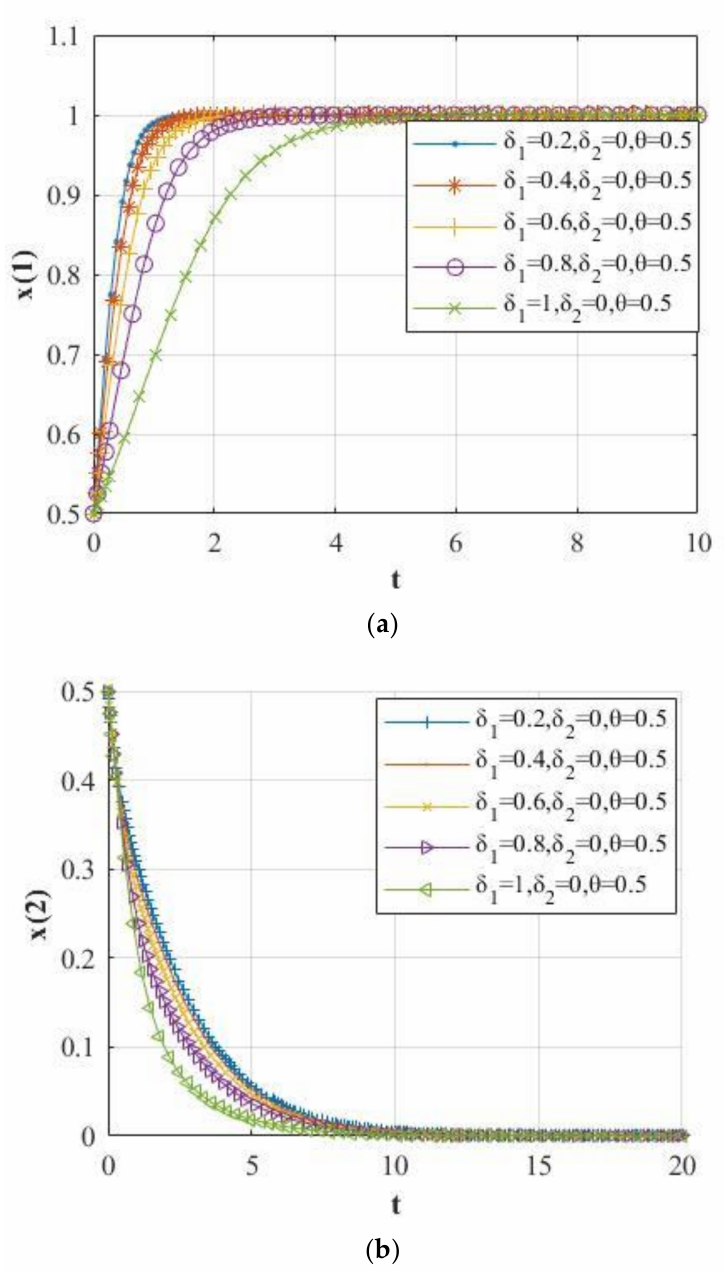
Figure 6. ( a ) While θ = 0.5 and changing δ 1 , evolution diagram of government’s supervision option. ( b ) While θ = 0.5 and changing δ 1 , evolution diagram of platform’s supervision